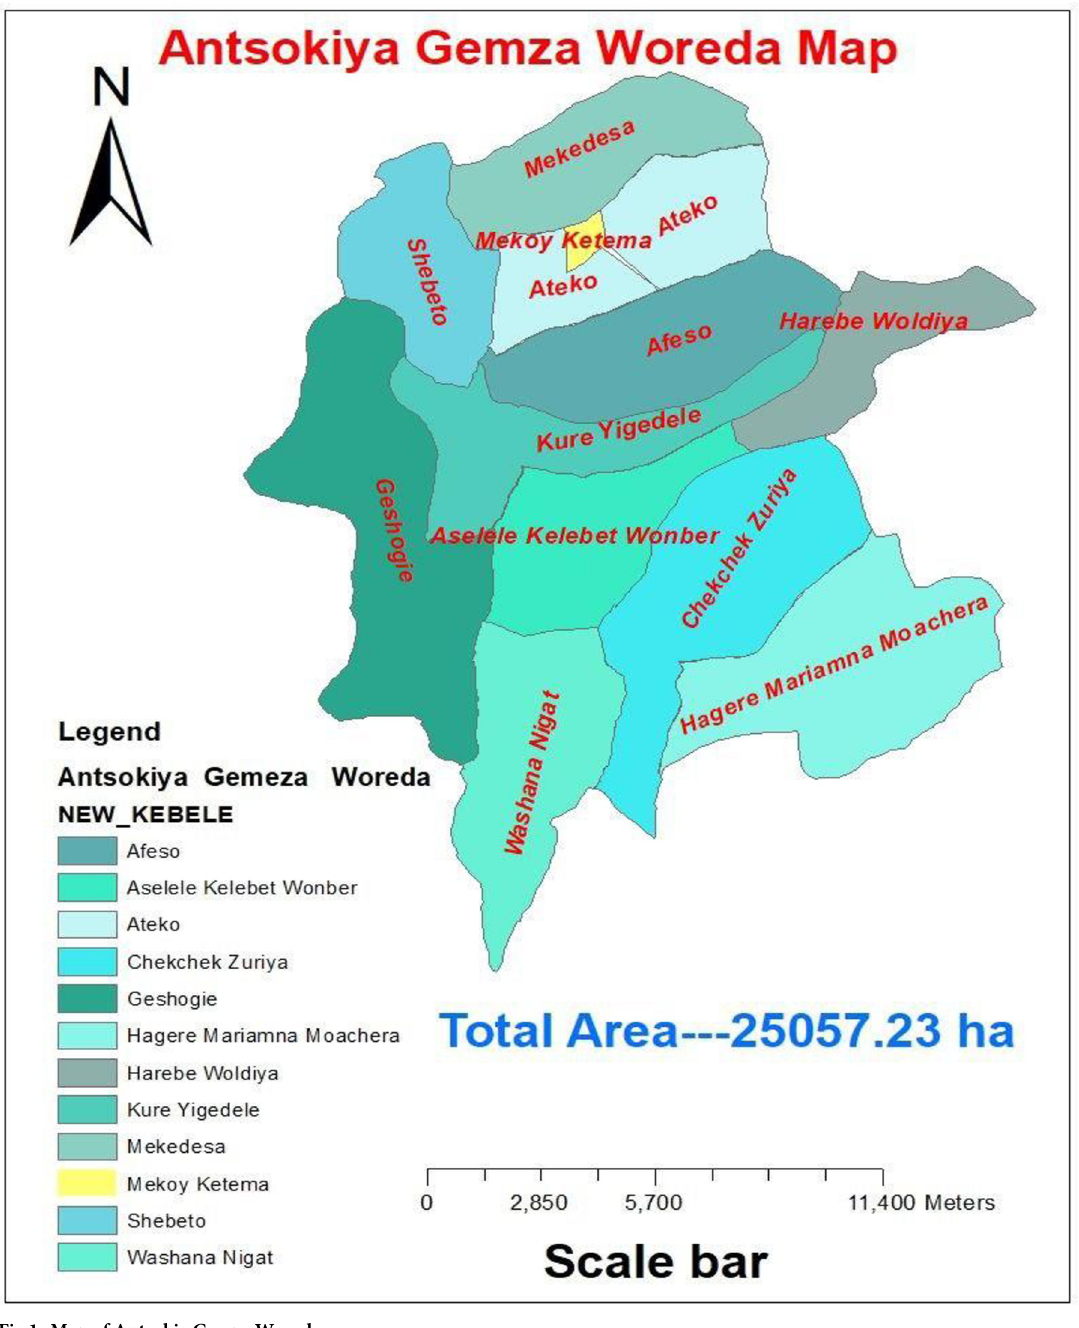
Fig 1. Map of Antsokia Gemza